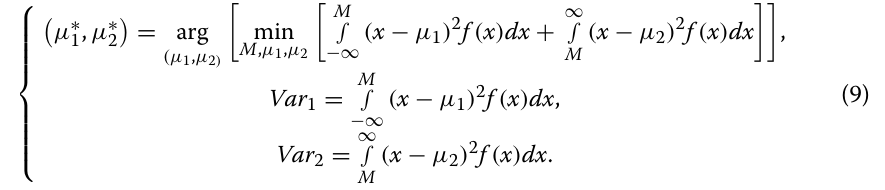
Scheme 1 : Normal distributions are often used for representing the real value random variables with unknown distributions [28, 29]. The joint probability density function of independent and identically normal distribution is given